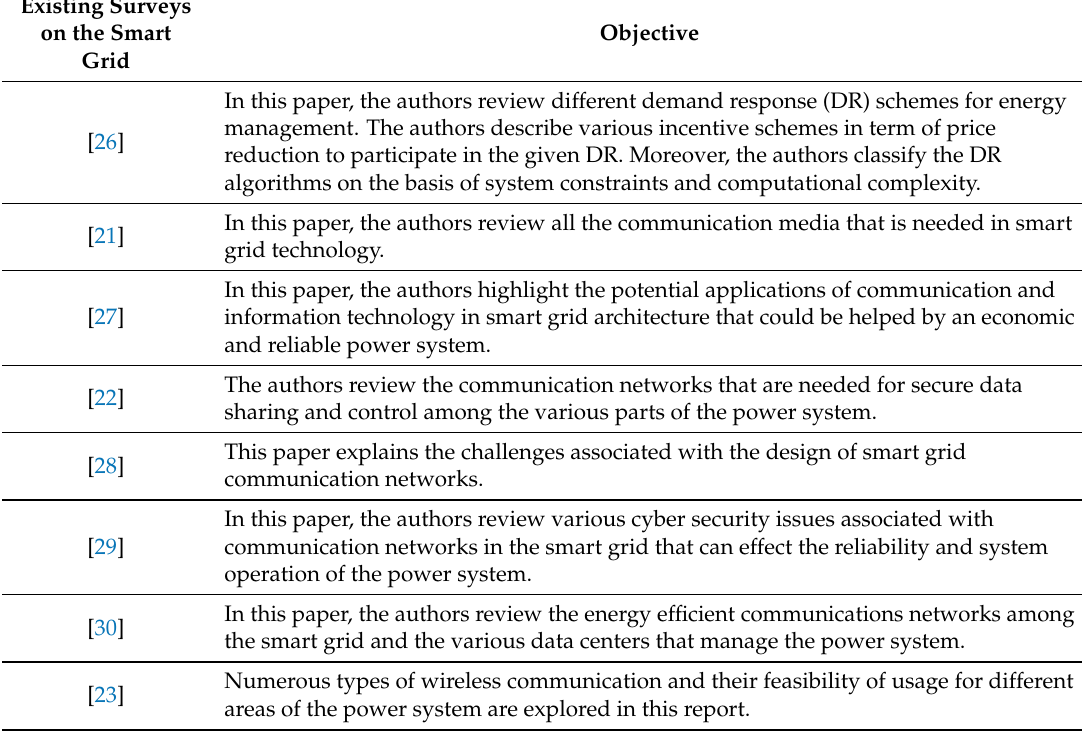
Table 3. Comparison between the existing surveys and our proposed